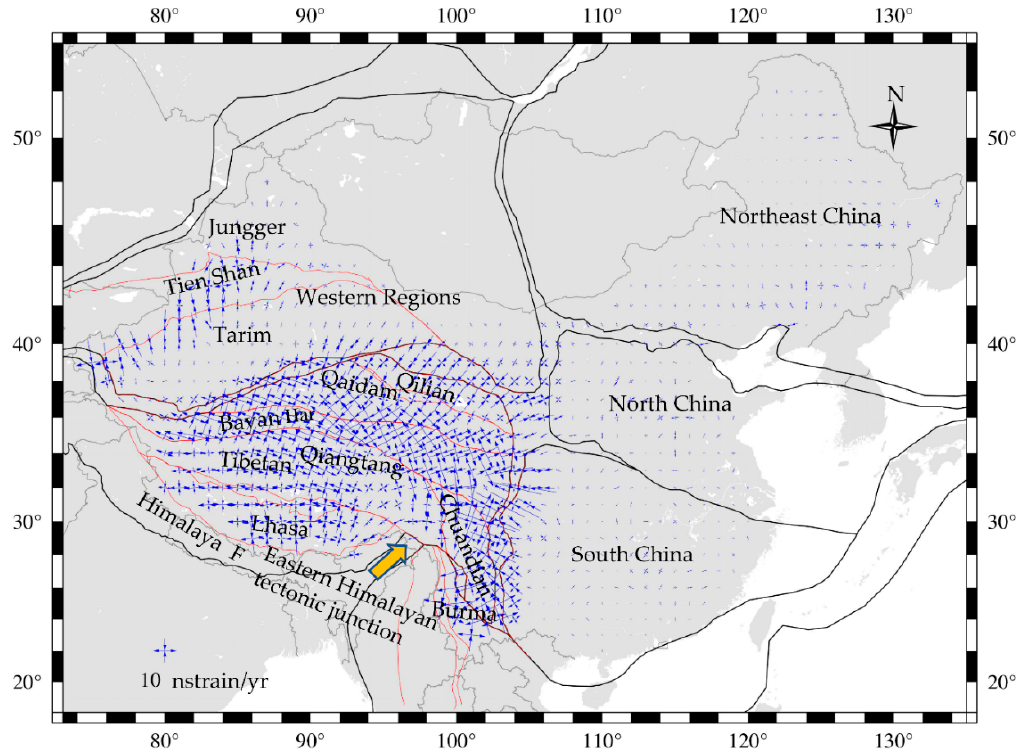
Figure 3. The horizontal strain rate distribution field in continental China. The black line is the boundary line of the first active block; The red line is part of the boundary line of the second active block; Chuandian represents Sichuan-Yunnan.